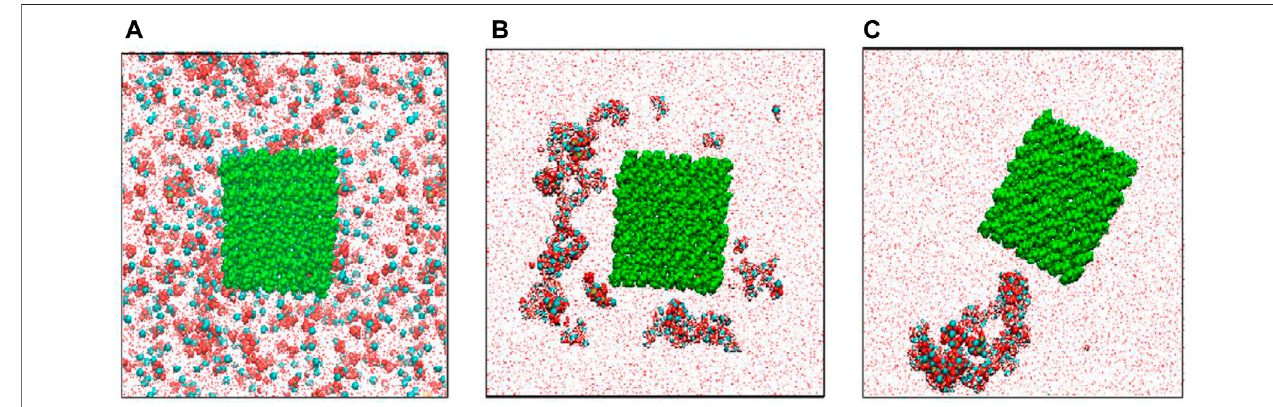
FIGURE1| Distributionsofionsinthemodelingcell: (A) intheinitialstate, (B) in12ns,and (C) attheend(100ns)ofsimulation.Redballs-Oatoms,cyanballs-Ca 2+ ions, yellow balls-P atoms, white balls-H atoms, green balls-cellulose atoms (Lukasheva and Tolmachev, 2016).